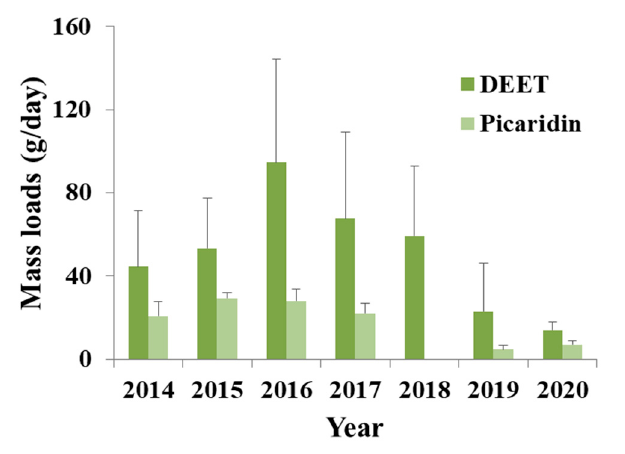
Figure 4. Mass loads of the most frequently detected insect repellents (N, N-diethyl-meta-toluamide (DEET) and picaridin) in influent wastewater collected in Athens.